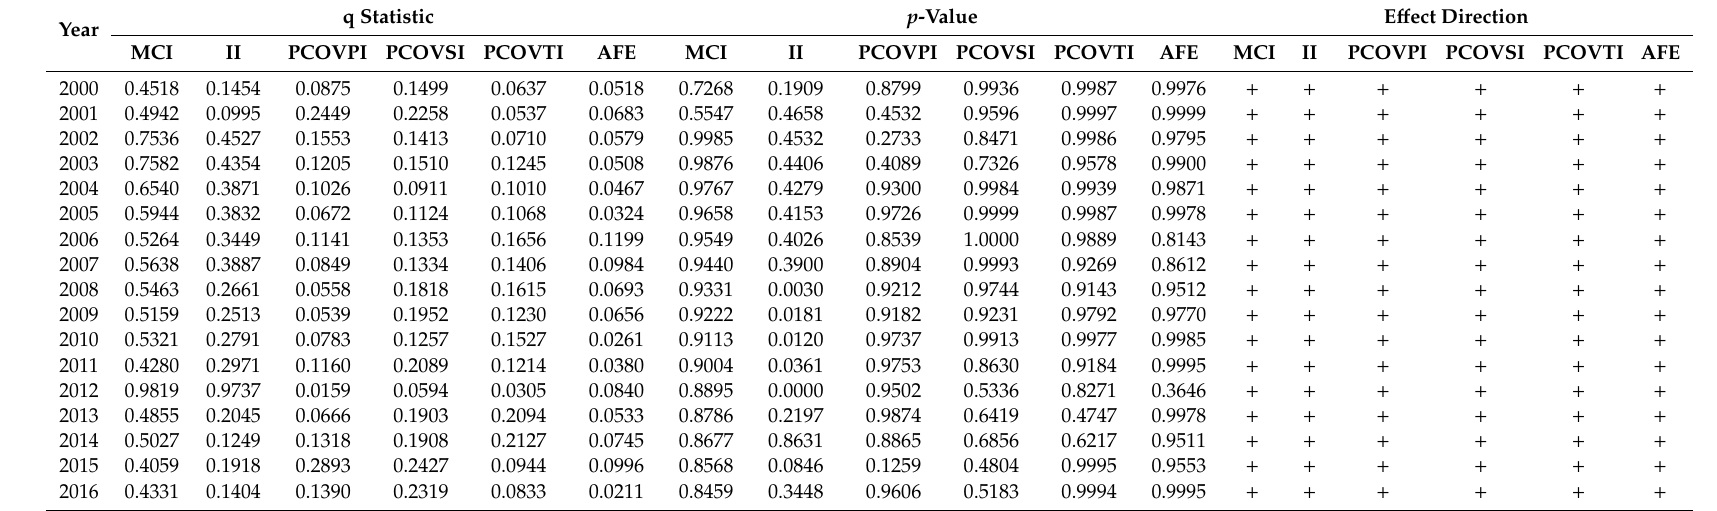
Table 7. Results of the E ff ects of Driving Factors on Agricultural Land Use